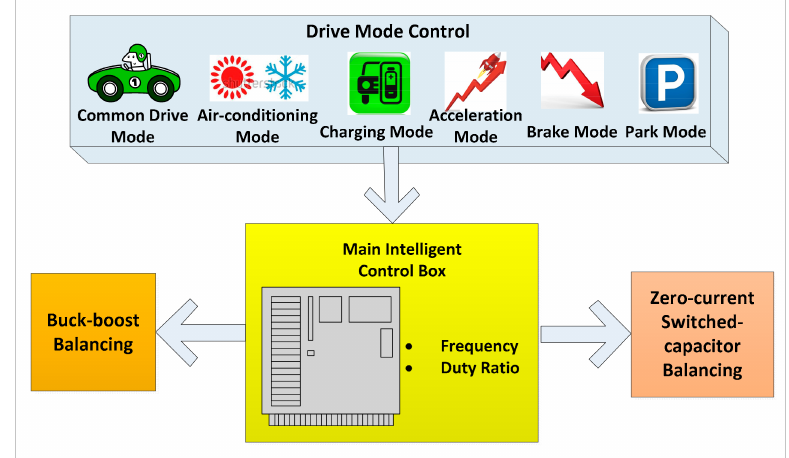
Figure 1. Di ff erent operating modes and